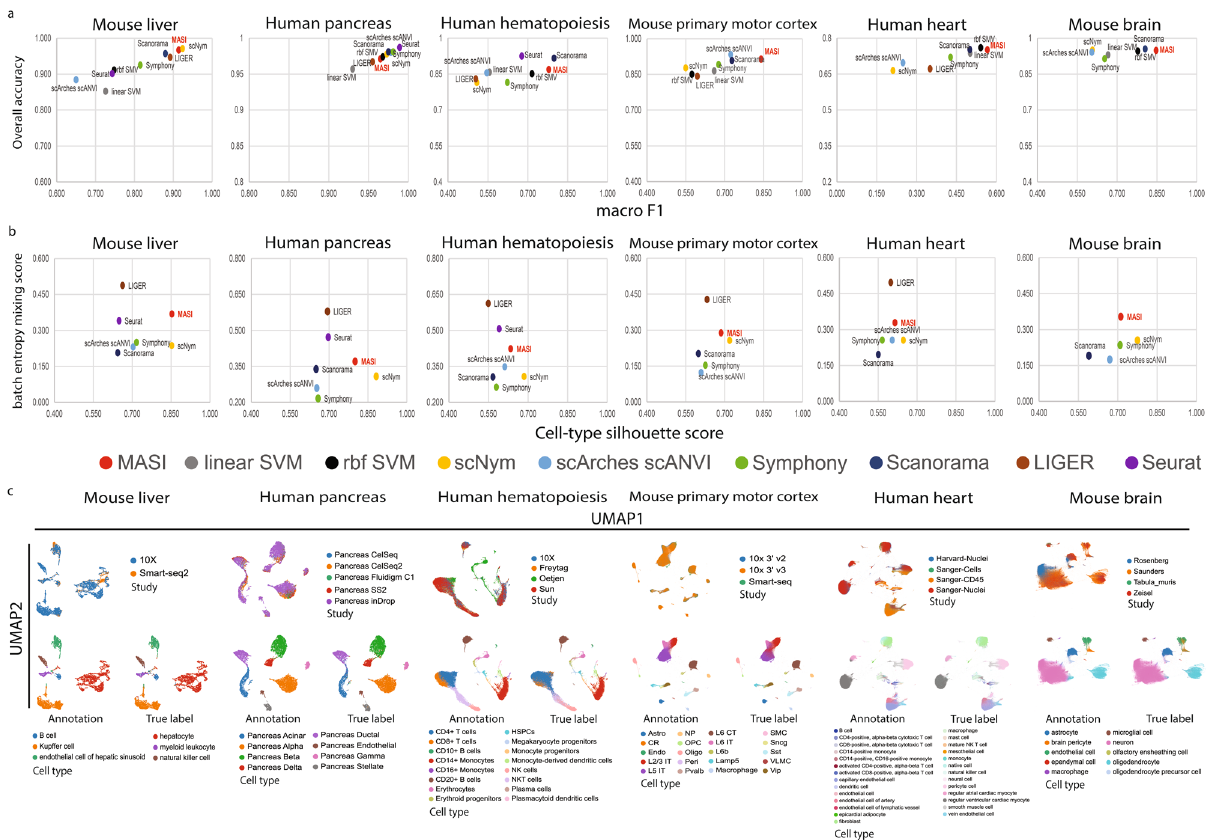
Fig. 3 Batch correction and label transferring benchmarks. a Comparison of label transferring for MASI, supervised, and semi-supervised methods. ACC: overall accuracy. Macro F1 is the average of F1 scores per cell type. A higher score in both metrics suggests better cell-type prediction. b Comparison of batch correction for MASI, scNym 10 , scArches scANVI 11 , Symphony 17 , Scanorama 16 , LIGER 6 and Seurat 7 . Cell-type silhouette score measures how well the integrated representation by these methods preserves cell-type variation, while the batch entropy mixing score measures how well the same cell type from different batches is mixed. c Visualization of MASI integration through UMAP. Cells are colored according to MASI-reported annotation (top left), author- reported annotation (top right), and batch id (bottom